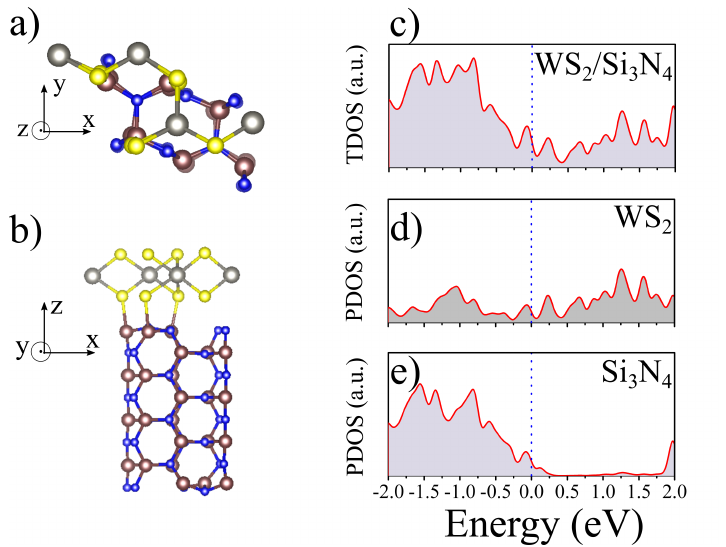
Figure 4. The relaxed atomic positions from the MD run are shown in ( a ) top and ( b ) side views of the heterojunction. The total density of states (TDOS) of the system is depicted in ( c ), while the partial density of states (PDOS) due to the WS 2 fraction is shown in ( d ), and the PDOS for Si 3 N 4 substrate is shown in ( e